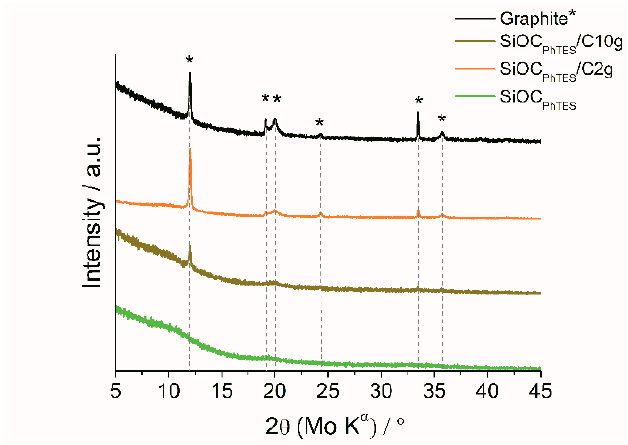
Figure 3. Diffractograms of pure graphite, ceramic and SiOC/graphite composites. Figure 3. Di ff ractograms of pure graphite, ceramic and SiOC / graphite composites. * is in the legend of the graph, meaning the di ff raction peaks for